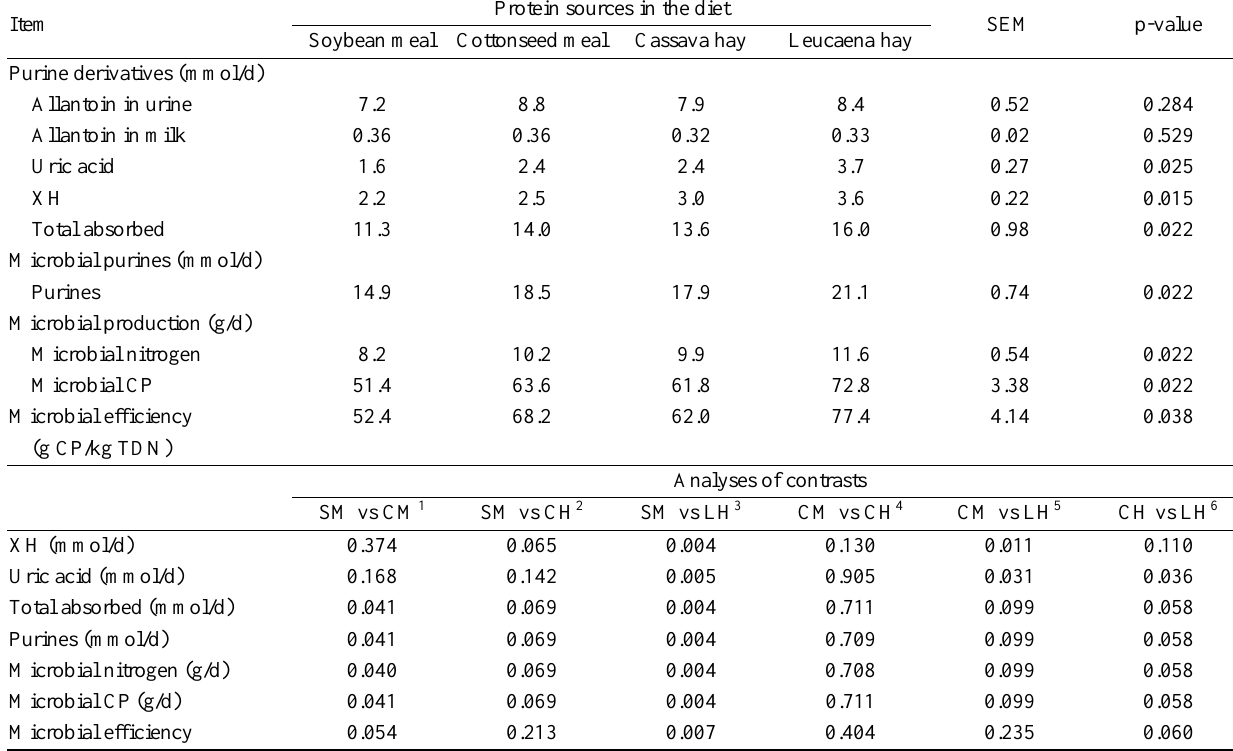
Protein sources in the